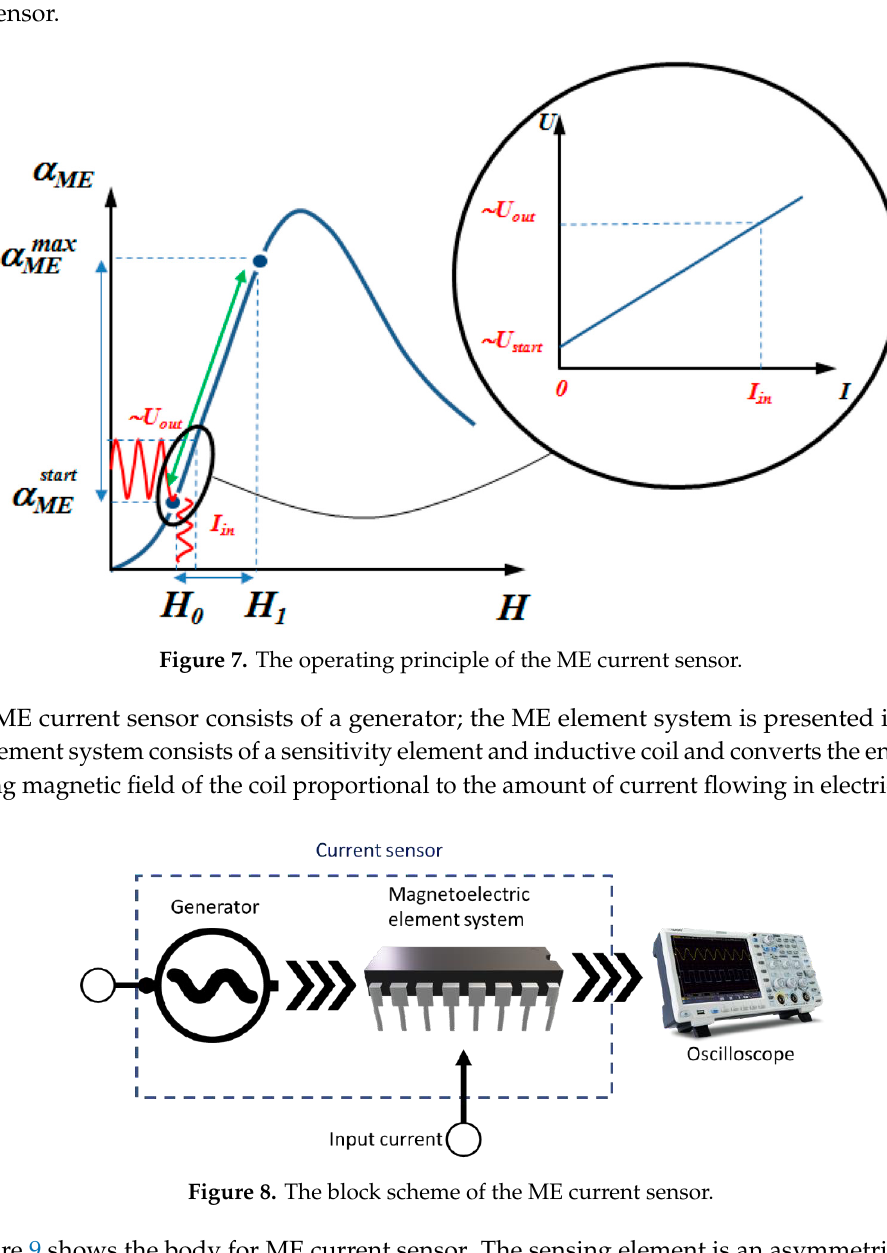
Figure 8. The block scheme of the ME current sensor.